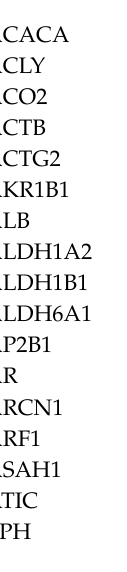
Table S1. Clinical data: Baseline clinical data for patients with PCa and BPH are provided. Table S2 . List of di ff erentially abundant proteins: number of peptides belonging to protein, fold change, p -value (Mann Whitney test) and normalised protein abundance in individual samples are given. Fold change was calculated as a ratio between average protein abundance in patients with PCa and average protein abundance in patients with